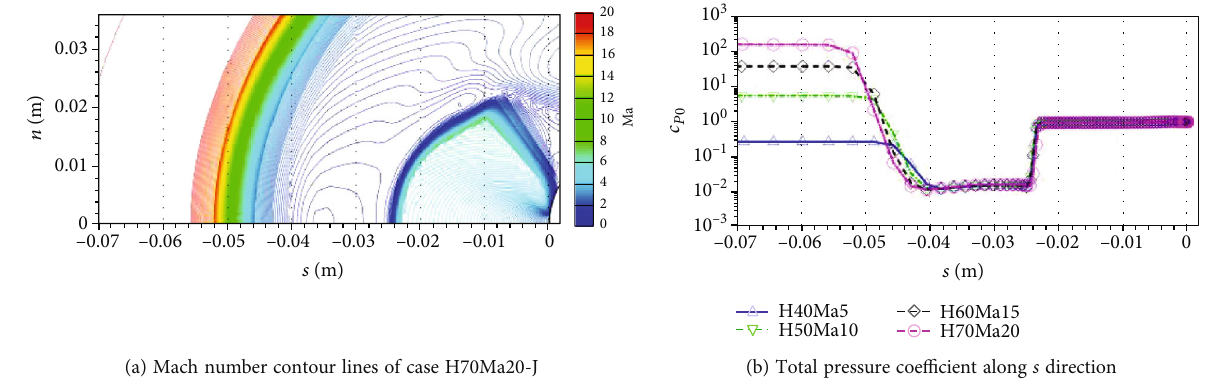
Figure 13: Typical jet fl ow structure and total pressure coe ffi cient analysis along s direction.